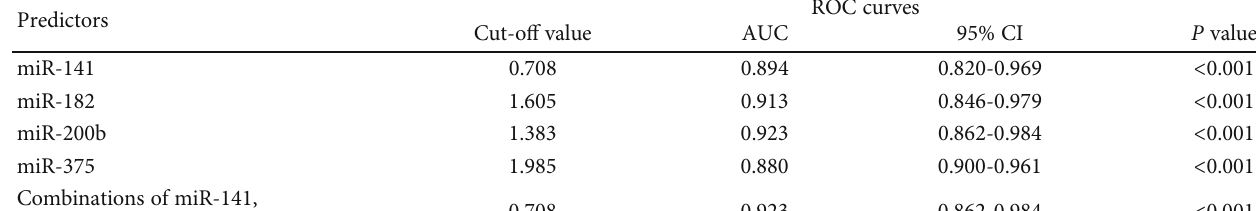
Table 3: ROC analysis of miRNAs.